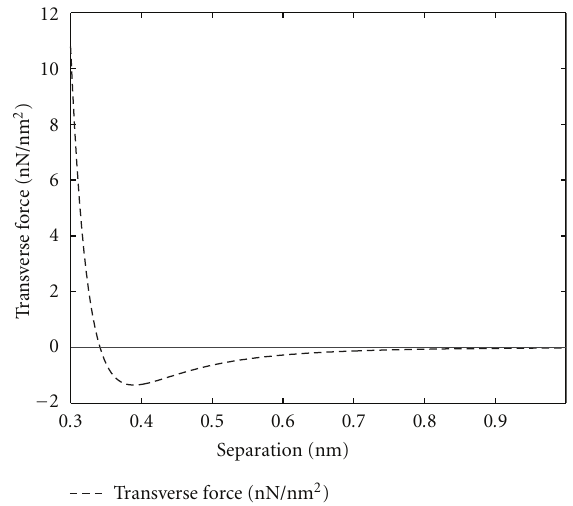
= 2 . 43 × 10 − 6 nNnm 7 6